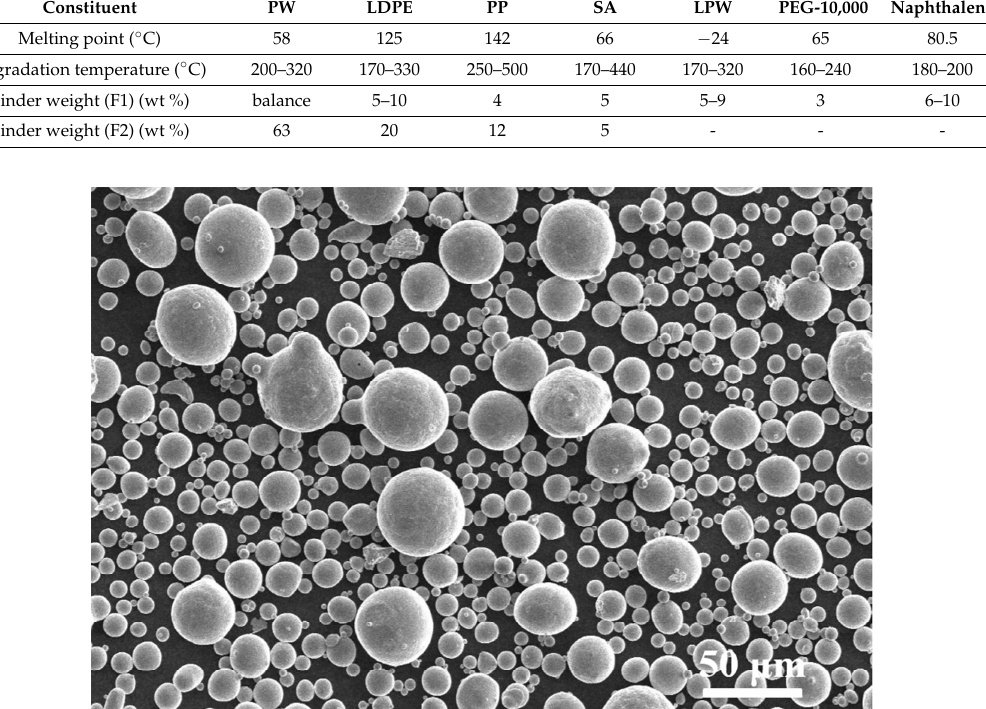
Figure 1. Morphology of the gas-atomised Ti-45Al-8.5Nb-0.2W-0.2B-0.02Y powder (sieved fraction <45 µm, d 50 = 32 µm).